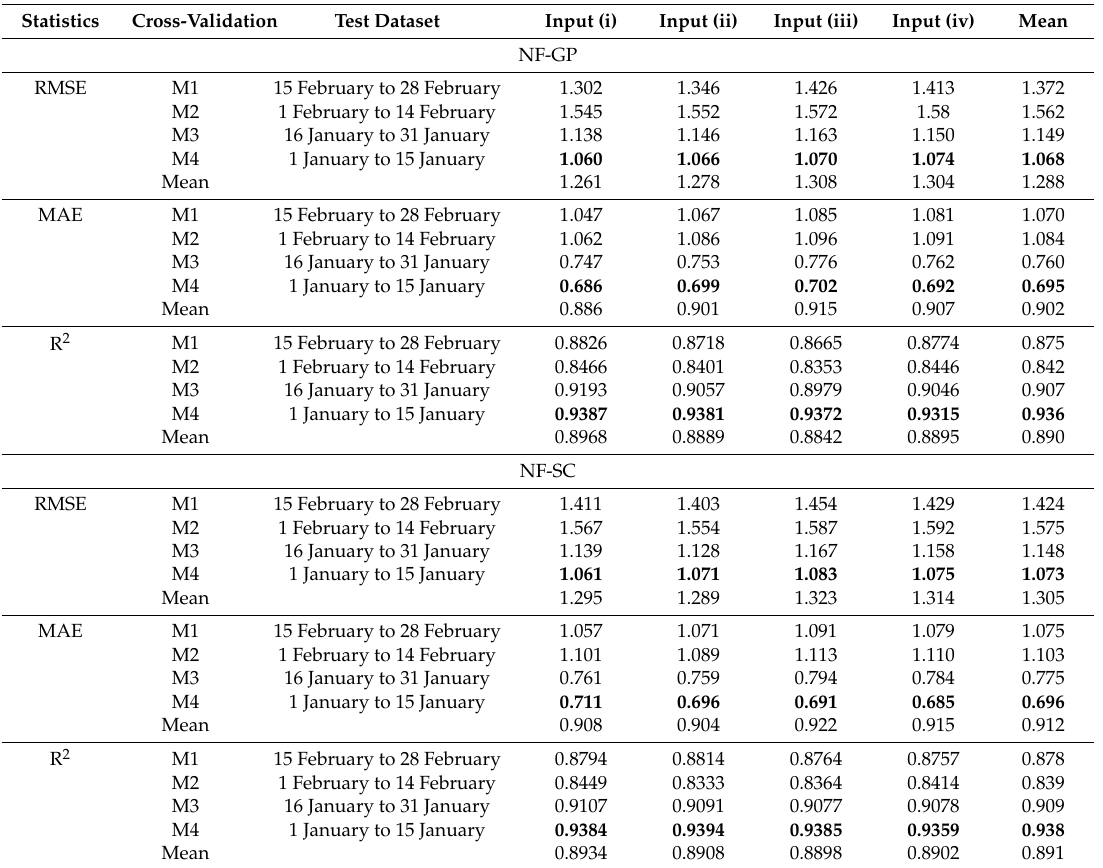
Table 7. NF-GP and NF-SC results in wind power prediction.